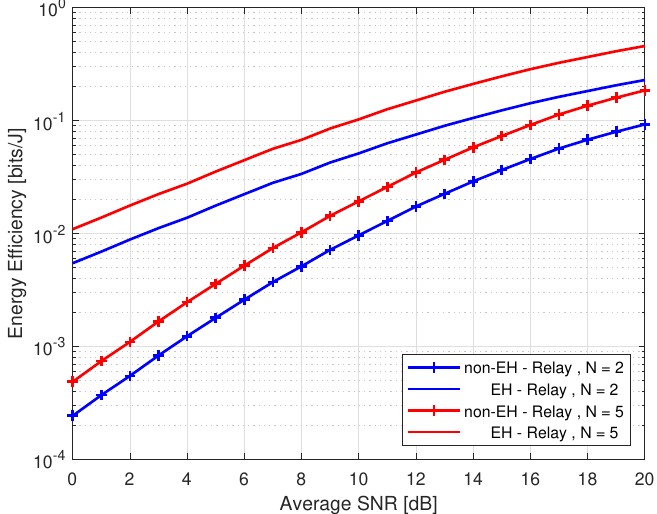
Figure 9. EE of conventional relaying and WEH relaying versus SNR for different N